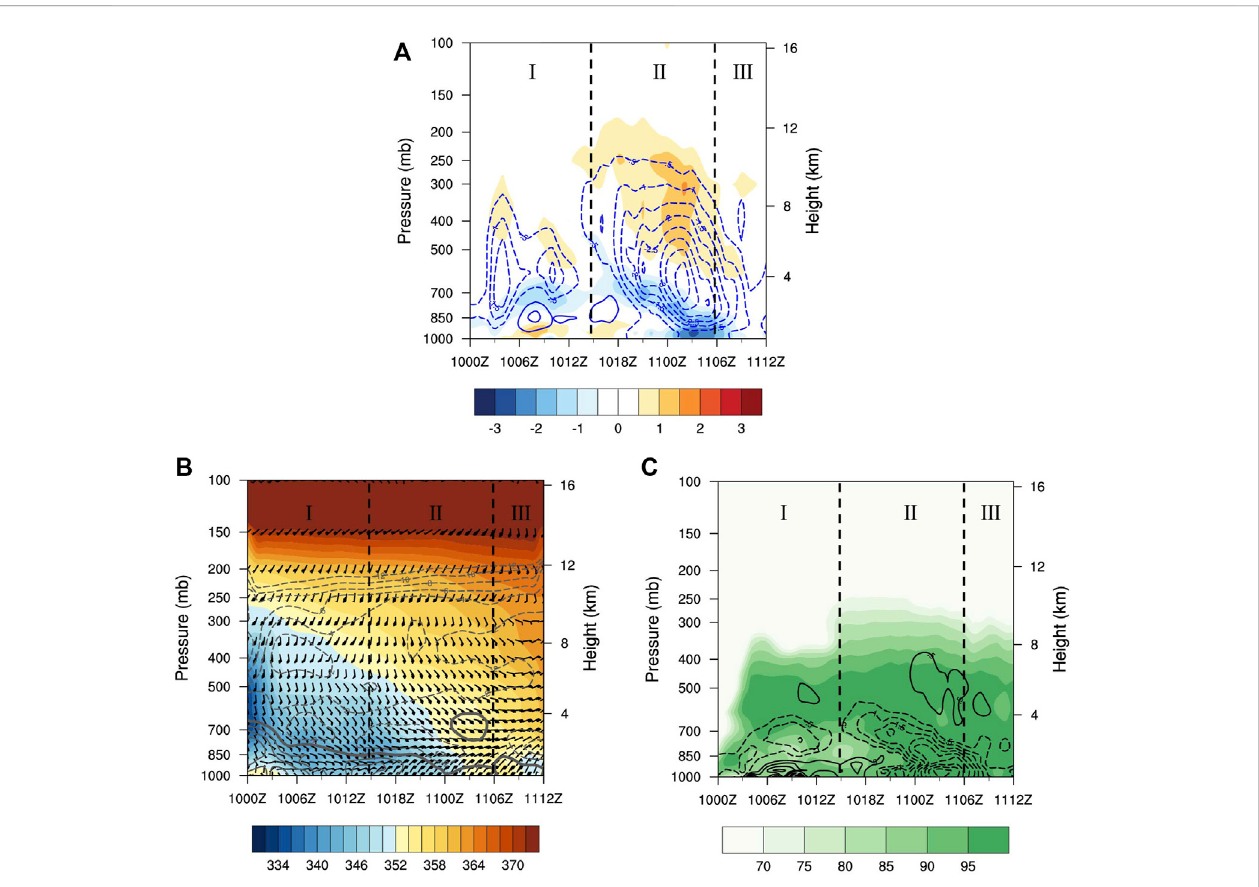
FIGURE 8 Time – heightseriesofarea-averaged (A) horizontaldivergence(shaded;unit:10 − 4 s − 1 )andverticalvelocity(contours,positivevaluesareinsolidcontours, negativevaluesareindashedcontours;unit:Pa/s); (B) equivalentpotentialtemperature(shaded;unit:K),equivalentpotentialtemperaturechangewithheight (contours, positive values are in solid contours, negative values are in dashed contours, zero values are in bold contours; unit: 10 − 2 K/hPa), and horizontal winds (barbs); (C) relative humidity (shaded; unit: %) and divergence of the horizontal water vapor fl ux (contours, positive values are in solid contours, negativevaluesareindashedcontours;unit:10 − 4 kg/(hPa · m 2 ·